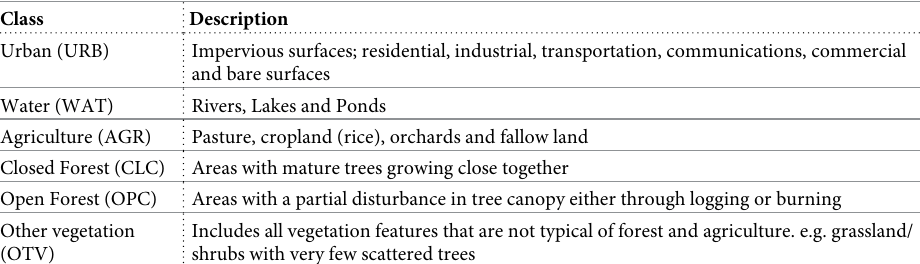
Table 1. Classes defined based on supervised